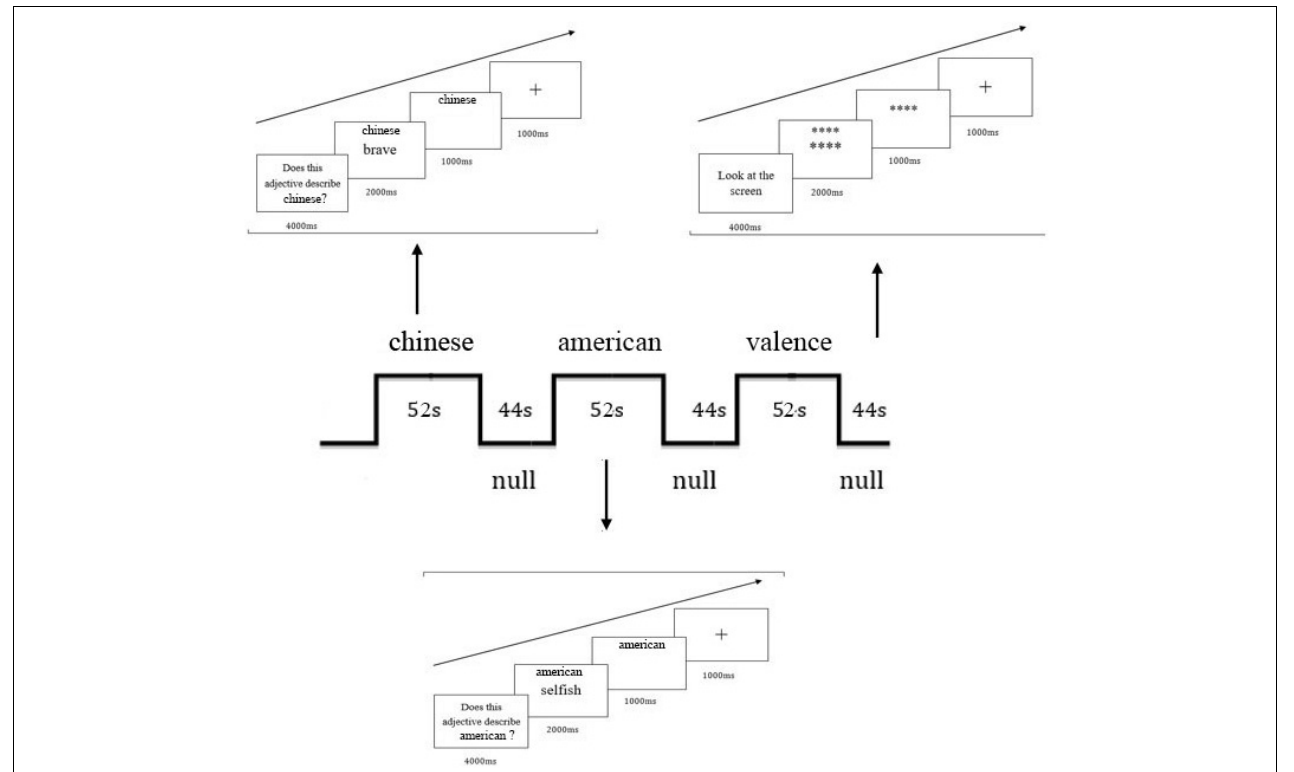
FIGURE 2 | Illustration of stimuli and procedure during collective-self